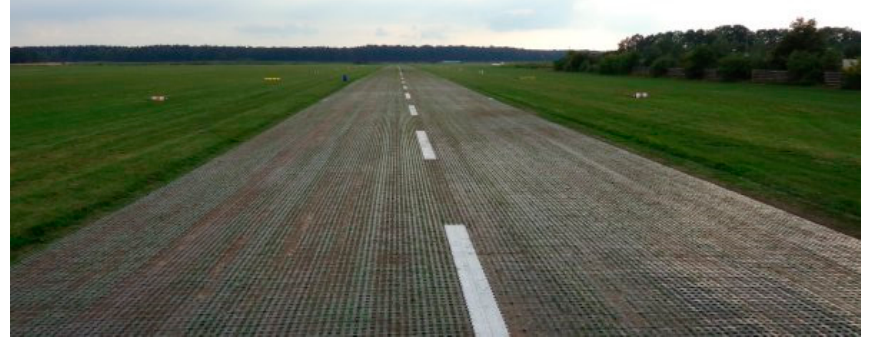
Figure 3. Solution made by the company PERFO.